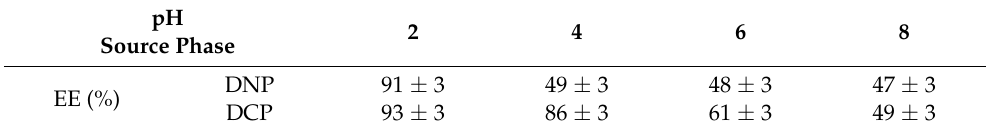
Table 5. 2,4–dinitrophenol (DNP) and 2,4-dichlorophenol (DCP) extraction efficiency (EE), depending on the pH of the source phase, after 150 min of